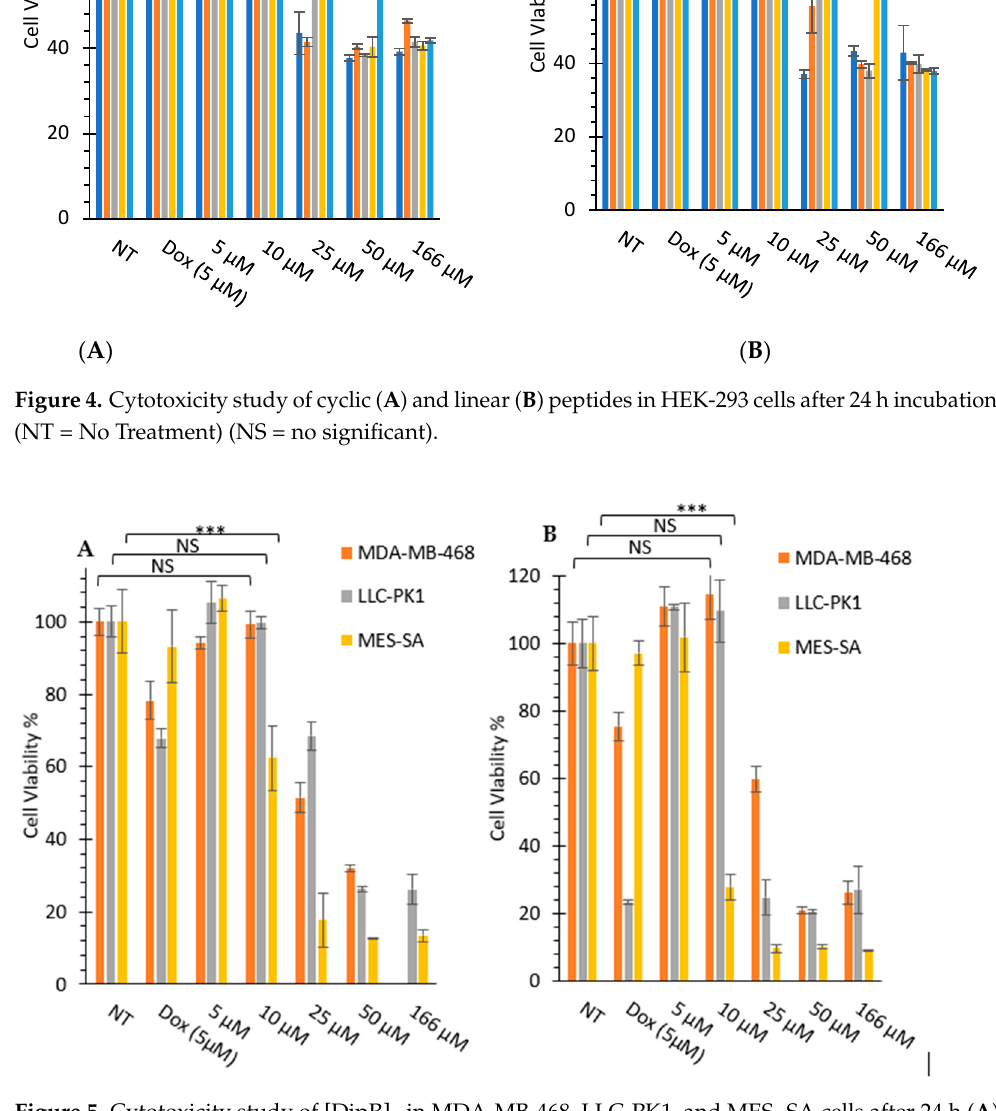
Figure 5. Cytotoxicity study of [DipR] 5 in MDA-MB-468, LLC-PK1, and MES- SA cells after 24 h ( A ) and 72 h; ( B ) incubation. Results are mean ± SD (n = 3) (NS = not significant, *** p < 0.001 treatment vs. no treatment (NT)).